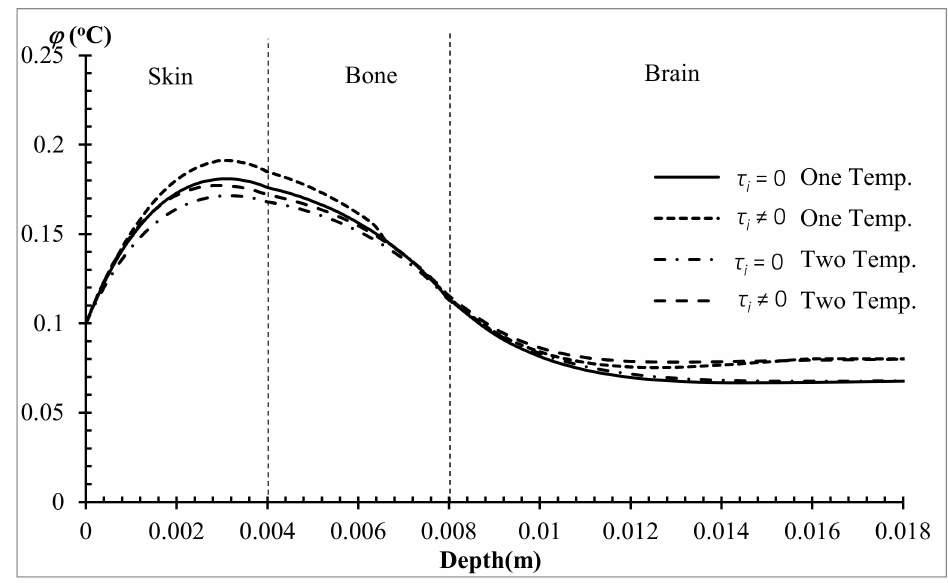
Figure 8. The conductive temperature increment with various relaxation times on an adult’s head.